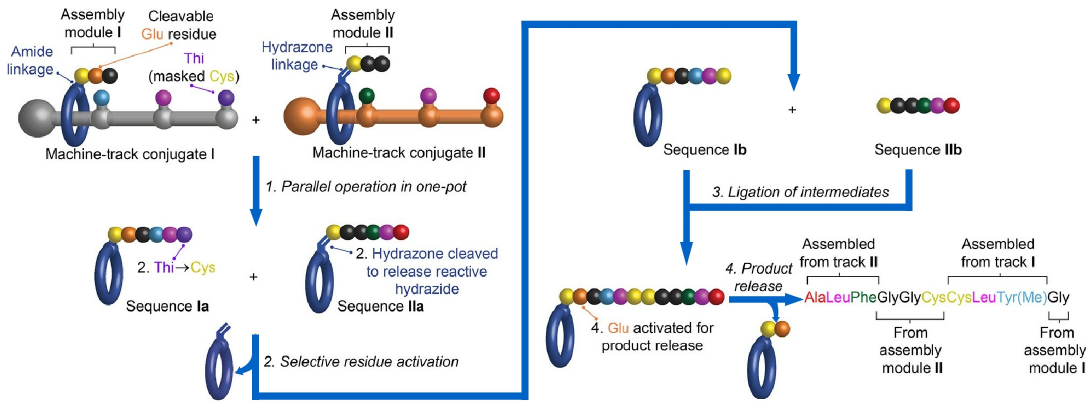
Figure 7. Molecular nanoarchitectonics of decapeptides by parallel manipulation of rotaxane-based molecular machines. Reprinted with permission from Reference [134]. Copyright 2021 American Chemical Society.